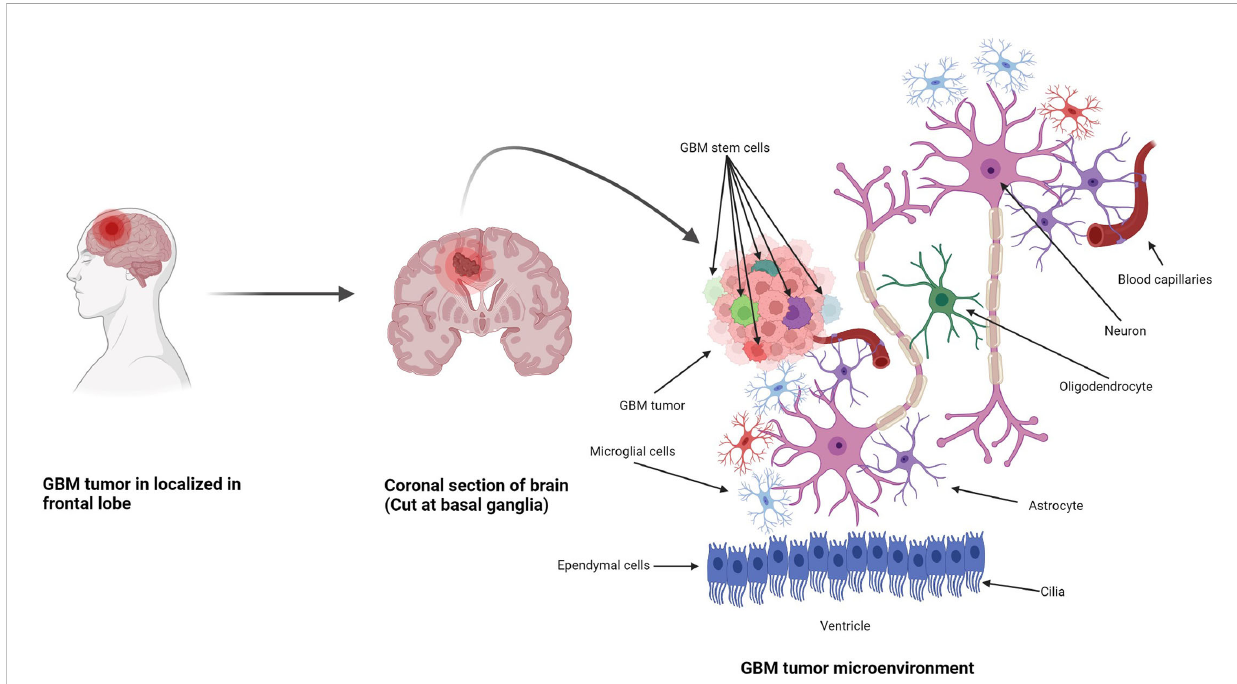
FIGURE 1 Formation of GBM tumors and their microenvironment. GBM tumors are often diagnosed in the frontal lobe, temporal lobe, and cerebellum (21). GBM tumor cells are composed of heterogenous cell populations (containing GMB stem cell markers (GSCs) in green, dark red, green dark green, purple, etc.) with properties of neural stem-like cells (NSCs): self-renewal, generation into differentiated GBM cells (22). The GBM microenvironment contains a variety of glial-type-associated cells including microglia and astrocytes, which are highly associated with glioma pathophysiology (23,